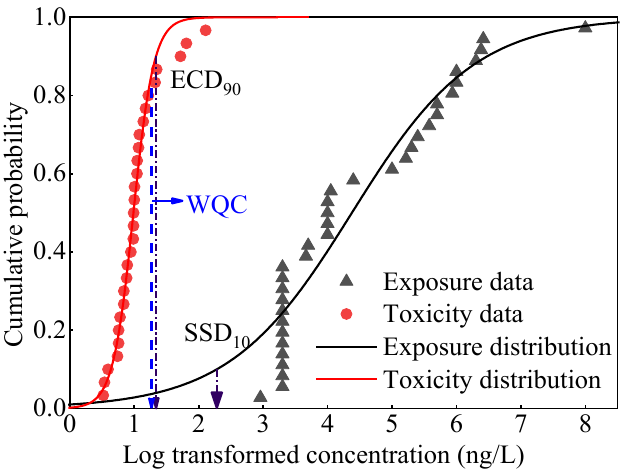
Figure 5. Distribution of exposure concentration and toxicity data of carbamazepine.